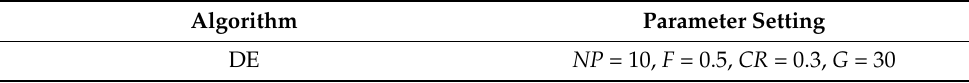
Table 5. The parameter settings for the architectural